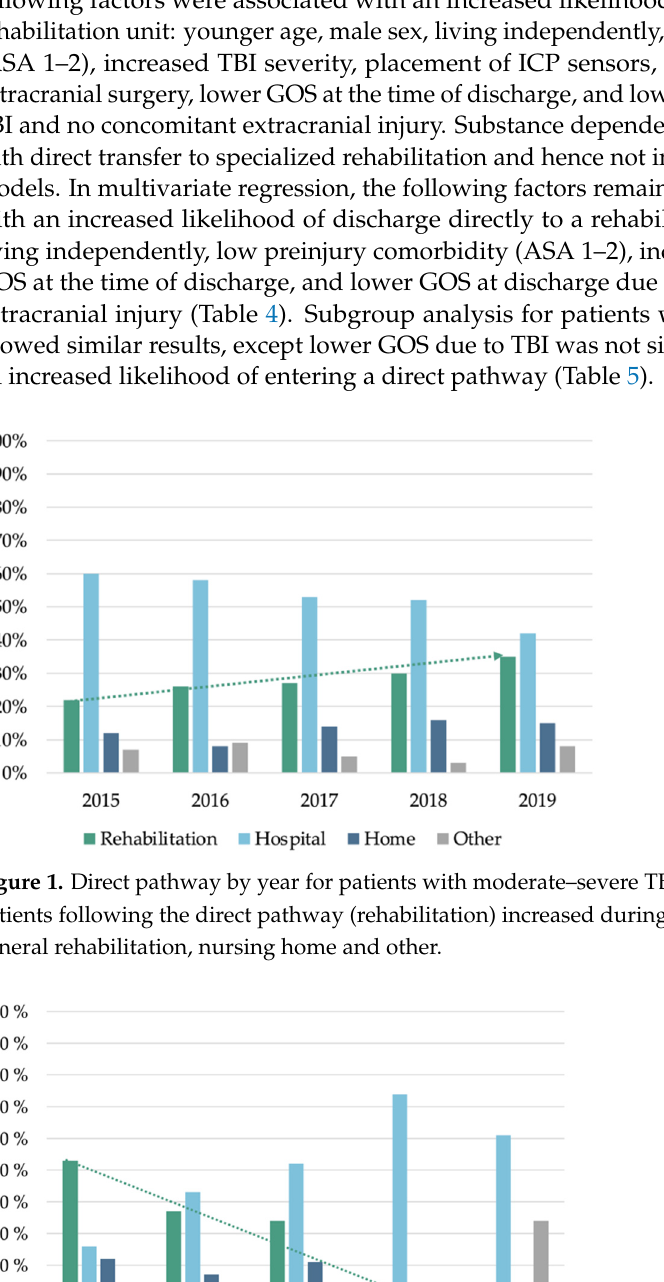
Figure 2. Direct pathway by age strata for patients with moderate–severe TBI ( n = 873). The percentage following the direct pathway (rehabilitation) decreased with increasing age. “Other” includes general rehabilitation, nursing home and other.